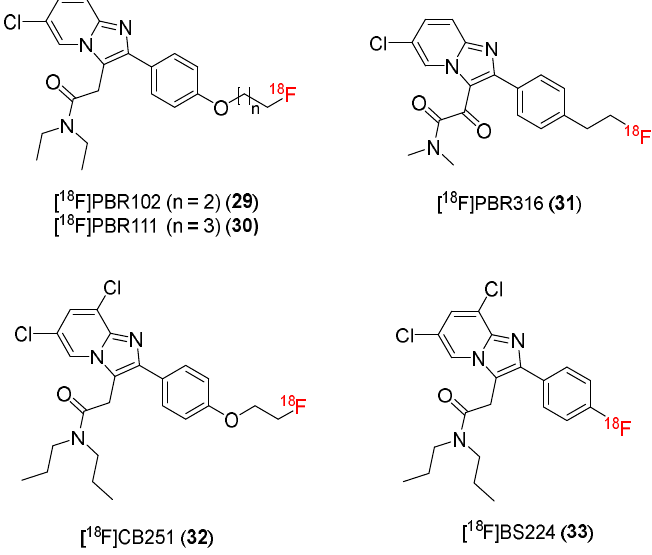
Figure 4. Structures of TSPO ligands containing imidazopyridine acetamide.